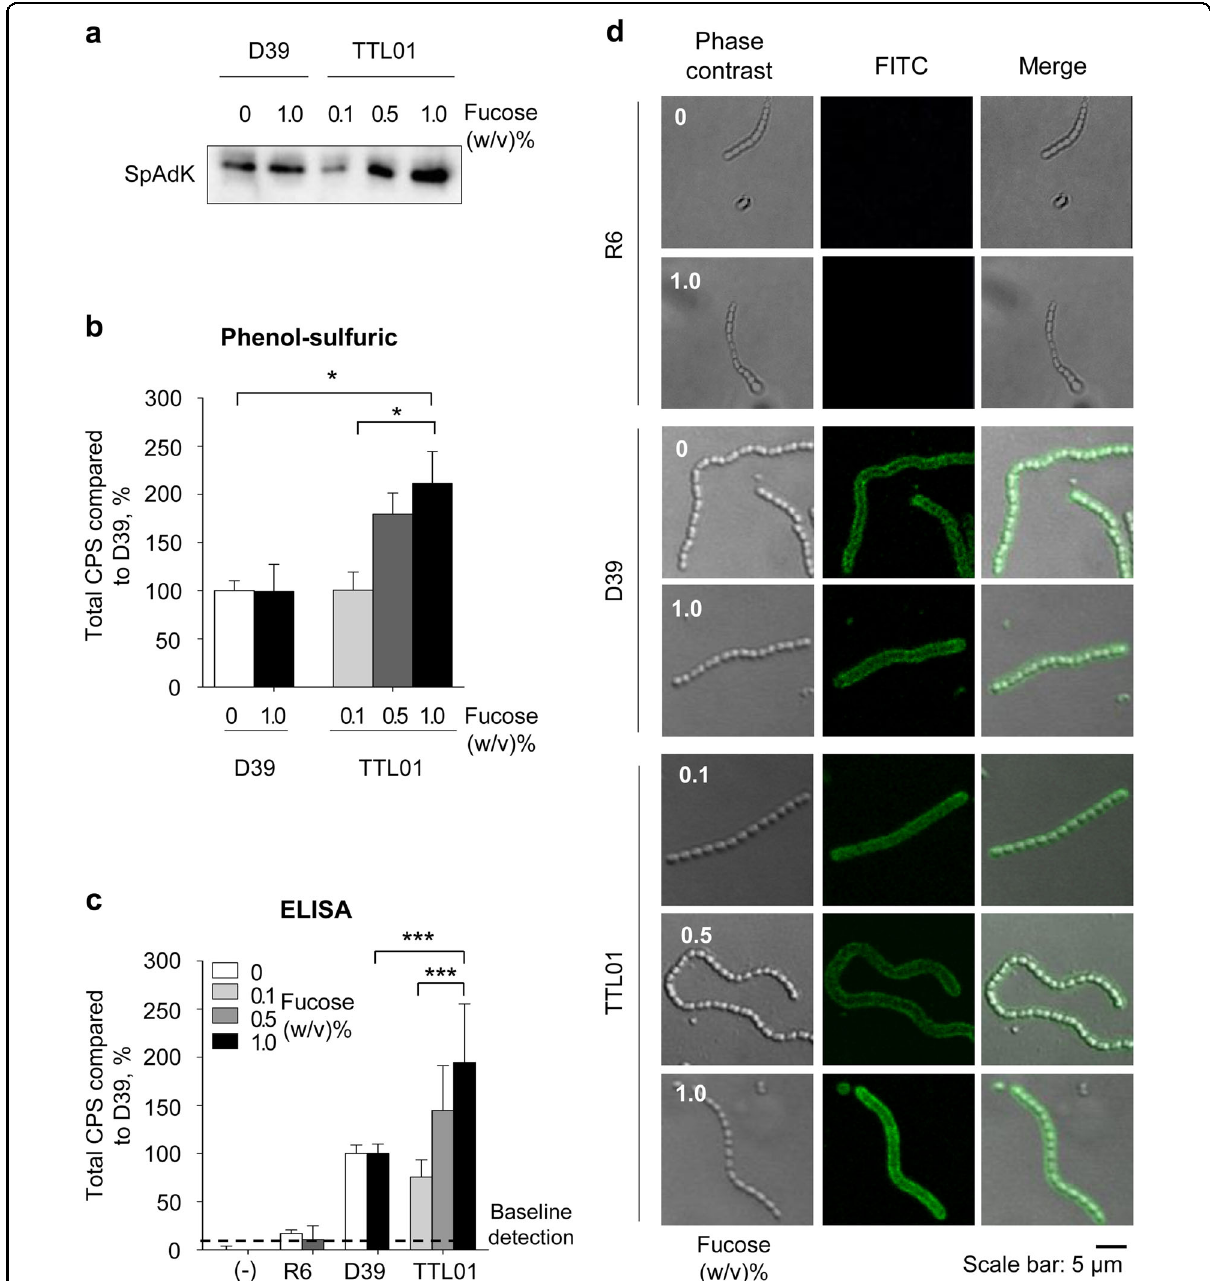
Fig. 1 SpAdK expression increases capsular polysaccharide (CPS) levels. a Protein levels of SpAdK from lysates of S. pneumoniae D39 WT and TTL01 strains under various concentrations of fucose. b , c Total CPS from whole-cell lysates of S. pneumoniae D39 WT and TTL01 strains under various concentrations of fucose was isolated, and the amount was measured using ( b ) the phenol – sulfuric method and c ELISA after cross-reacting with the type 2 CPS antiserum. All samples were assayed in triplicate, and each assay was repeated three times. Signi fi cant differences were analyzed by one- way ANOVA (* P ≤ 0.05 and *** P ≤ 0.001). d FITC-labeled CPS of S. pneumoniae was visualized by confocal microscopy. The data are representative